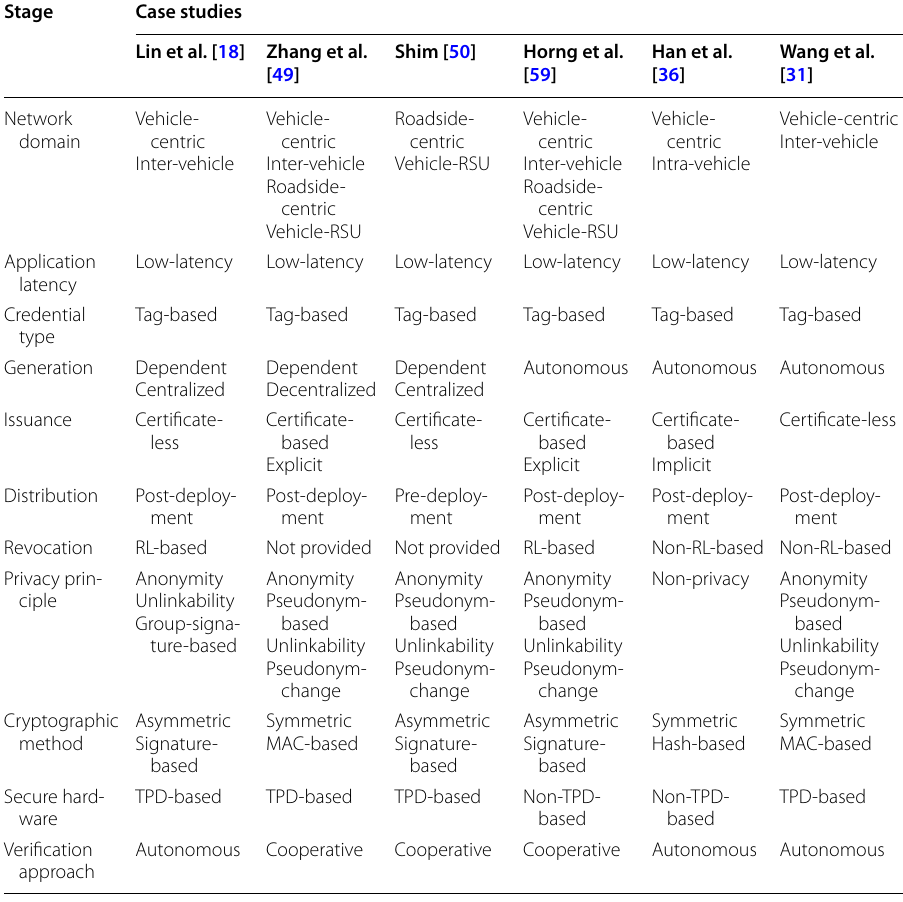
Table 2 Individual analysis of six different well-known authentication protocols